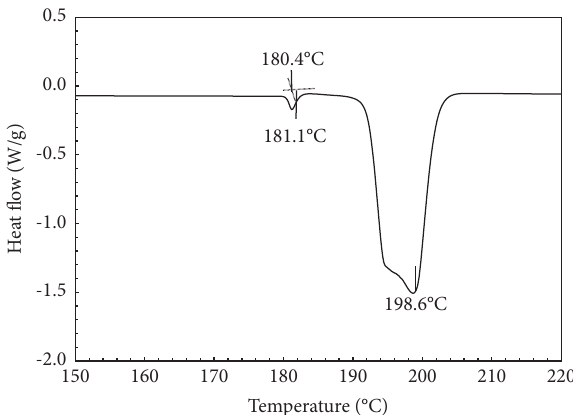
Figure 3: DSC analysis of the Sn